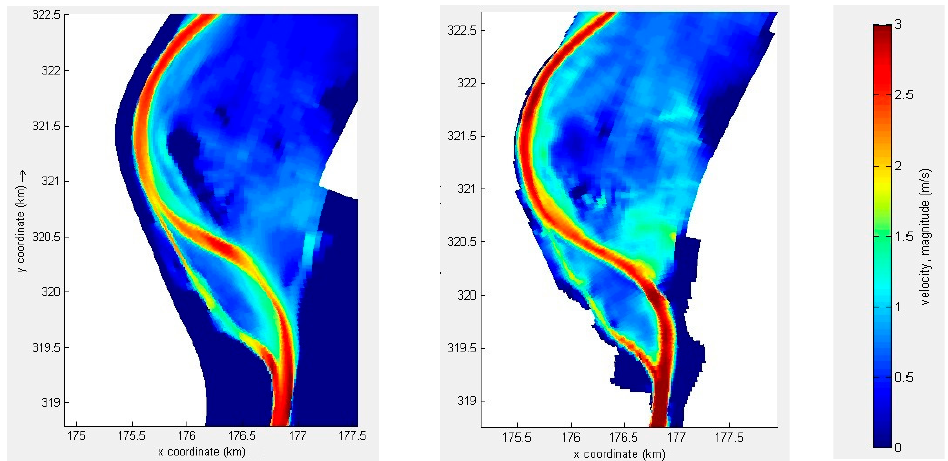
Figure 9. Illustration of water levels ( right panel ) and currents for the Grensmaas with currents in Delft3D-FLOW in blue and currents for “Semi-impl” in red ( left panel ).